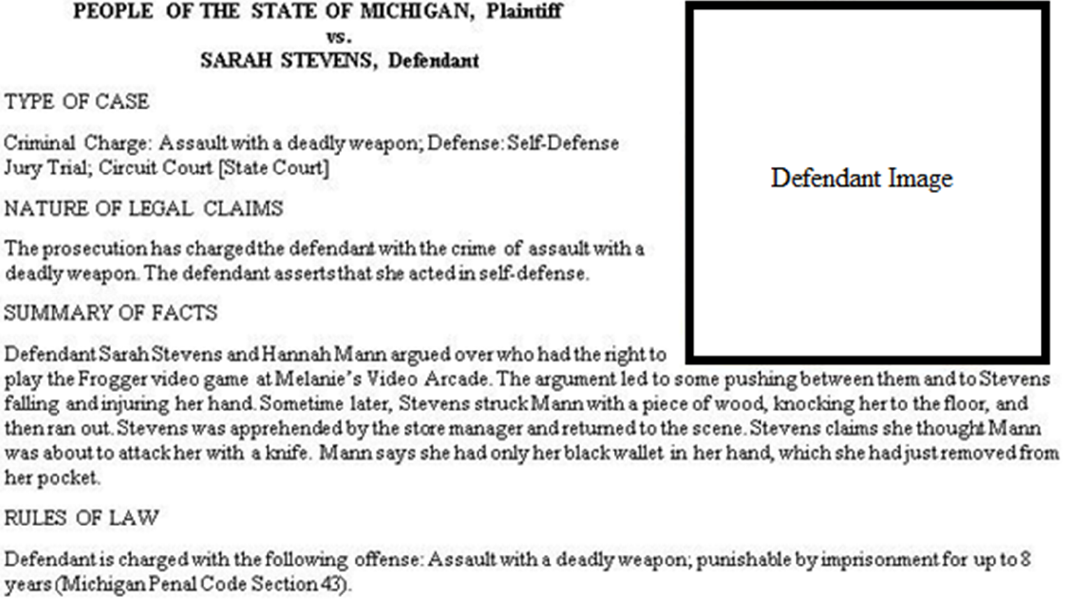
Figure A4. Fourth trial vignette used in Study 1.